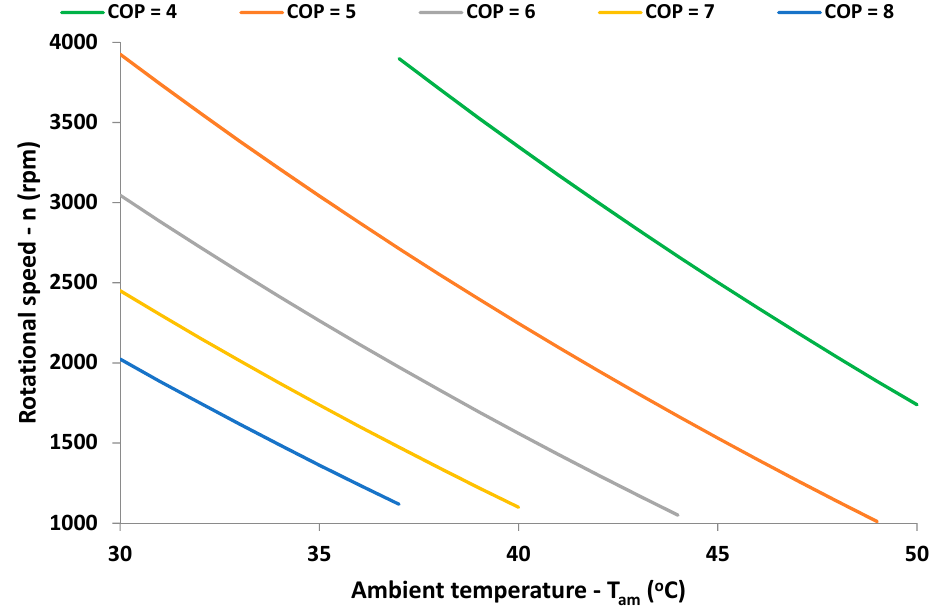
Figure 16. Cooling capacity for different ambient temperatures and COP ( T ind = 25 °C and 1000 rpm < n < 4000 rpm). Appl. Sci. 2018 , 8 , x FOR PEER REVIEW